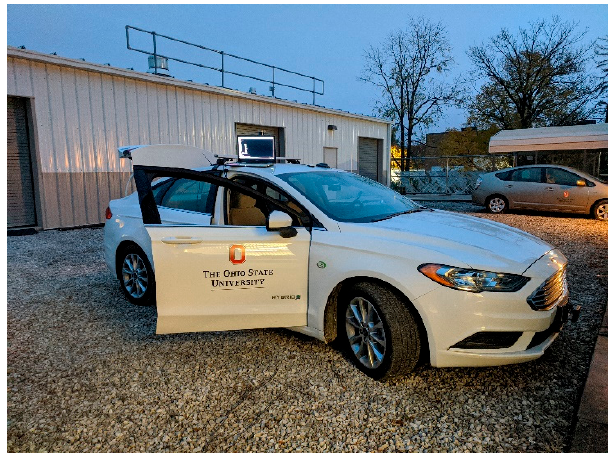
Figure 1. CAV platform Ford Fusion 2017 vehicle.